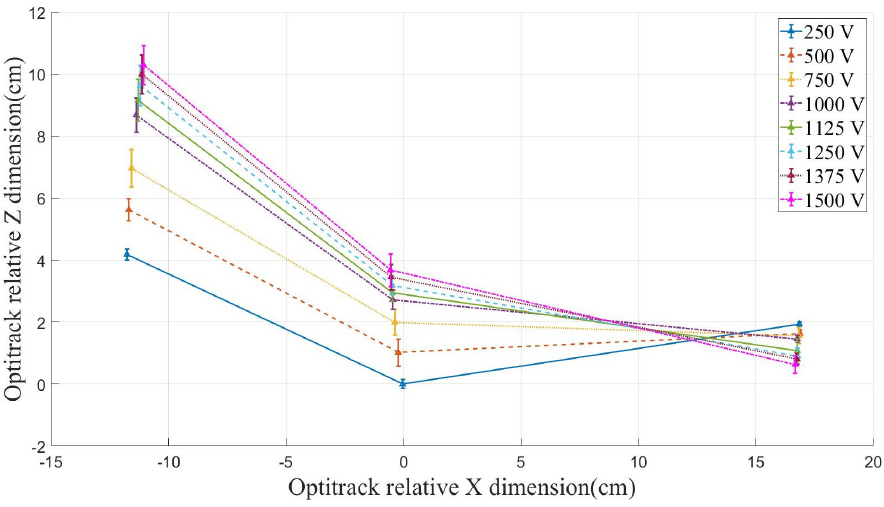
Figure 15. Tail twist repeatability experiments: Frontal